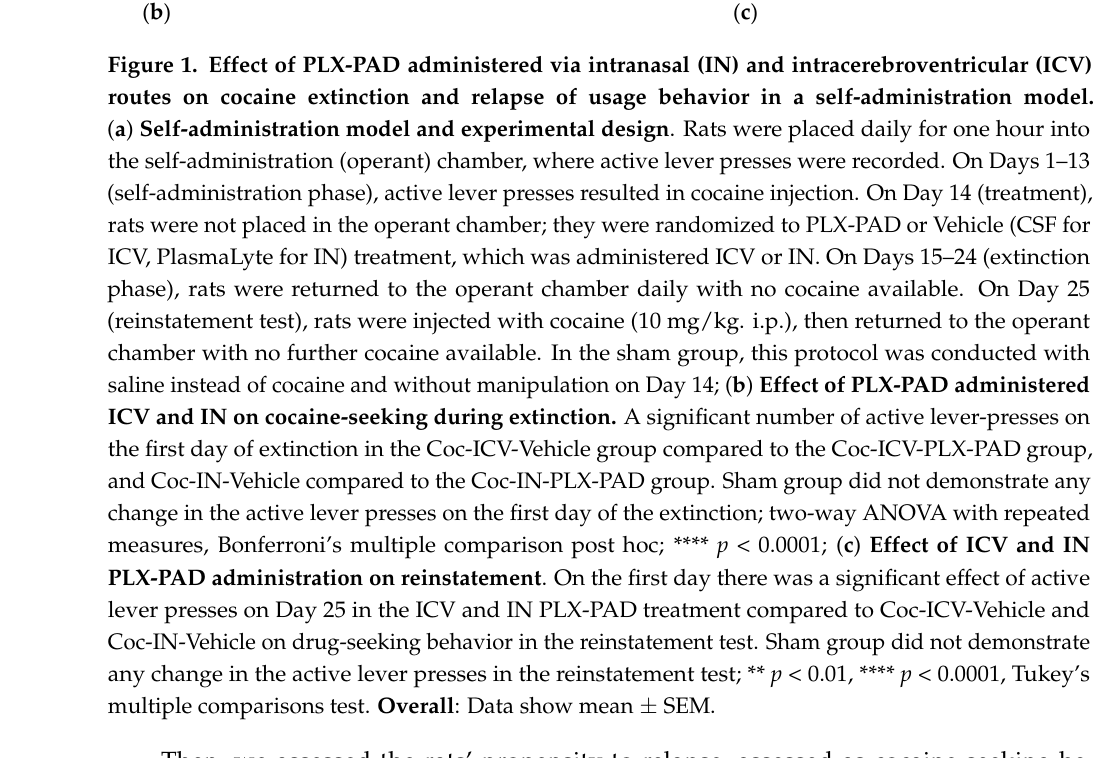
Figure 1. Effect of PLX-PAD administered via intranasal (IN) and intracerebroventricular (ICV) routes on cocaine extinction and relapse of usage behavior in a self-administration model. ( a ) Self-administration model and experimental design . Rats were placed daily for one hour into the self-administration (operant) chamber, where active lever presses were recorded. On Days 1–13 (self-administration phase), active lever presses resulted in cocaine injection. On Day 14 (treatment), rats were not placed in the operant chamber; they were randomized to PLX-PAD or Vehicle (CSF for ICV, PlasmaLyte for IN) treatment, which was administered ICV or IN. On Days 15–24 (extinction phase), rats were returned to the operant chamber daily with no cocaine available. On Day 25 (reinstatement test), rats were injected with cocaine (10 mg/kg. i.p.), then returned to the operant chamber with no further cocaine available. In the sham group, this protocol was conducted with saline instead of cocaine and without manipulation on Day 14; ( b ) Effect of PLX-PAD administered ICV and IN on cocaine-seeking during extinction. A significant number of active lever-presses on the first day of extinction in the Coc-ICV-Vehicle group compared to the Coc-ICV-PLX-PAD group, and Coc-IN-Vehicle compared to the Coc-IN-PLX-PAD group. Sham group did not demonstrate any change in the active lever presses on the first day of the extinction; two-way ANOVA with repeated measures, Bonferroni’s multiple comparison post hoc; **** p < 0.0001; ( c ) Effect of ICV and IN PLX-PAD administration on reinstatement . On the first day there was a significant effect of active lever presses on Day 25 in the ICV and IN PLX-PAD treatment compared to Coc-ICV-Vehicle and Coc-IN-Vehicle on drug-seeking behavior in the reinstatement test. Sham group did not demonstrate any change in the active lever presses in the reinstatement test; ** p < 0.01, **** p < 0.0001, Tukey’s multiple comparisons test. Overall : Data show mean ± SEM. Then, we assessed the rats’ propensity to relapse, assessed as cocaine-seeking be- havior (active lever presses) after cocaine reinstatement on Day 25 (Figure 1c).